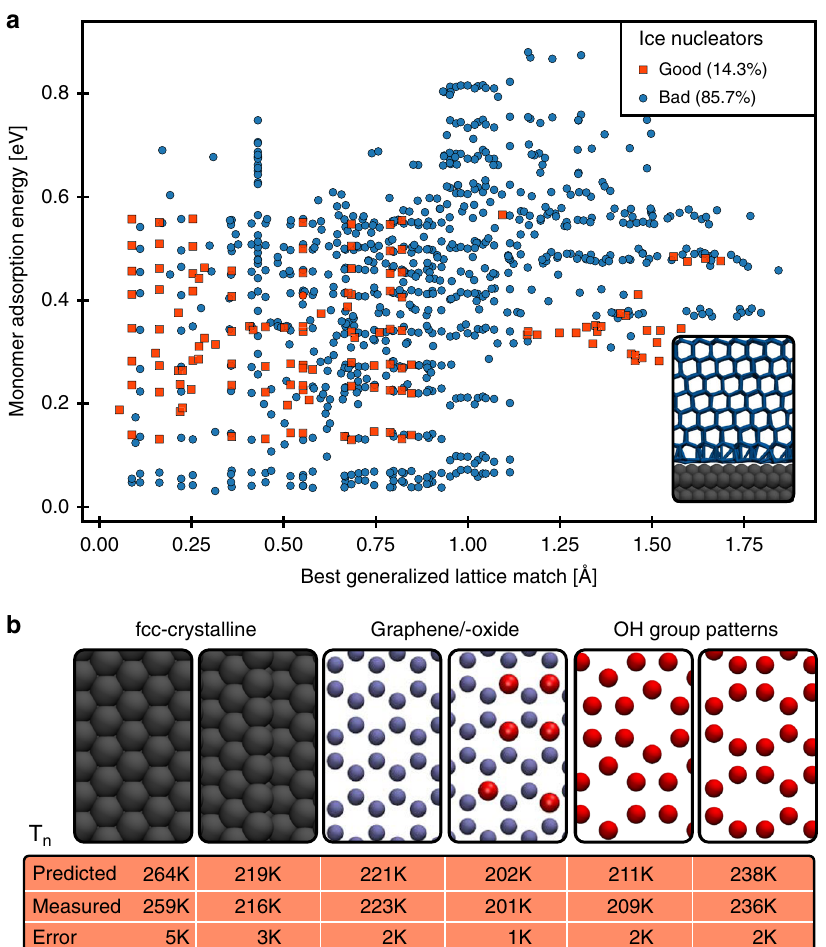
Fig. 1 Overview of the database examined and the performance of our ML model. a Scatterplot of monomer adsorption energy versus the best generalized lattice match for all substrates. Zero corresponds to a perfect lattice match between ice and the substrate. Substrates are classi fi ed as good ice nucleators if their nucleation temperature was above 225 K and as bad otherwise. The inset on the bottom right shows a side view of a typical simulation cell after the nucleation event. Source data are provided as a Source data fi le. b Exemplary substrates studied in this work (top down view): fcc-crystalline substrates with Lennard – Jones interaction (gray), graphitic surfaces (light blue) and OH-group patterns (red). The table below indicates measured nucleation temperatures and the prediction of our best ML model (when the respective substrate was outside of the training set).